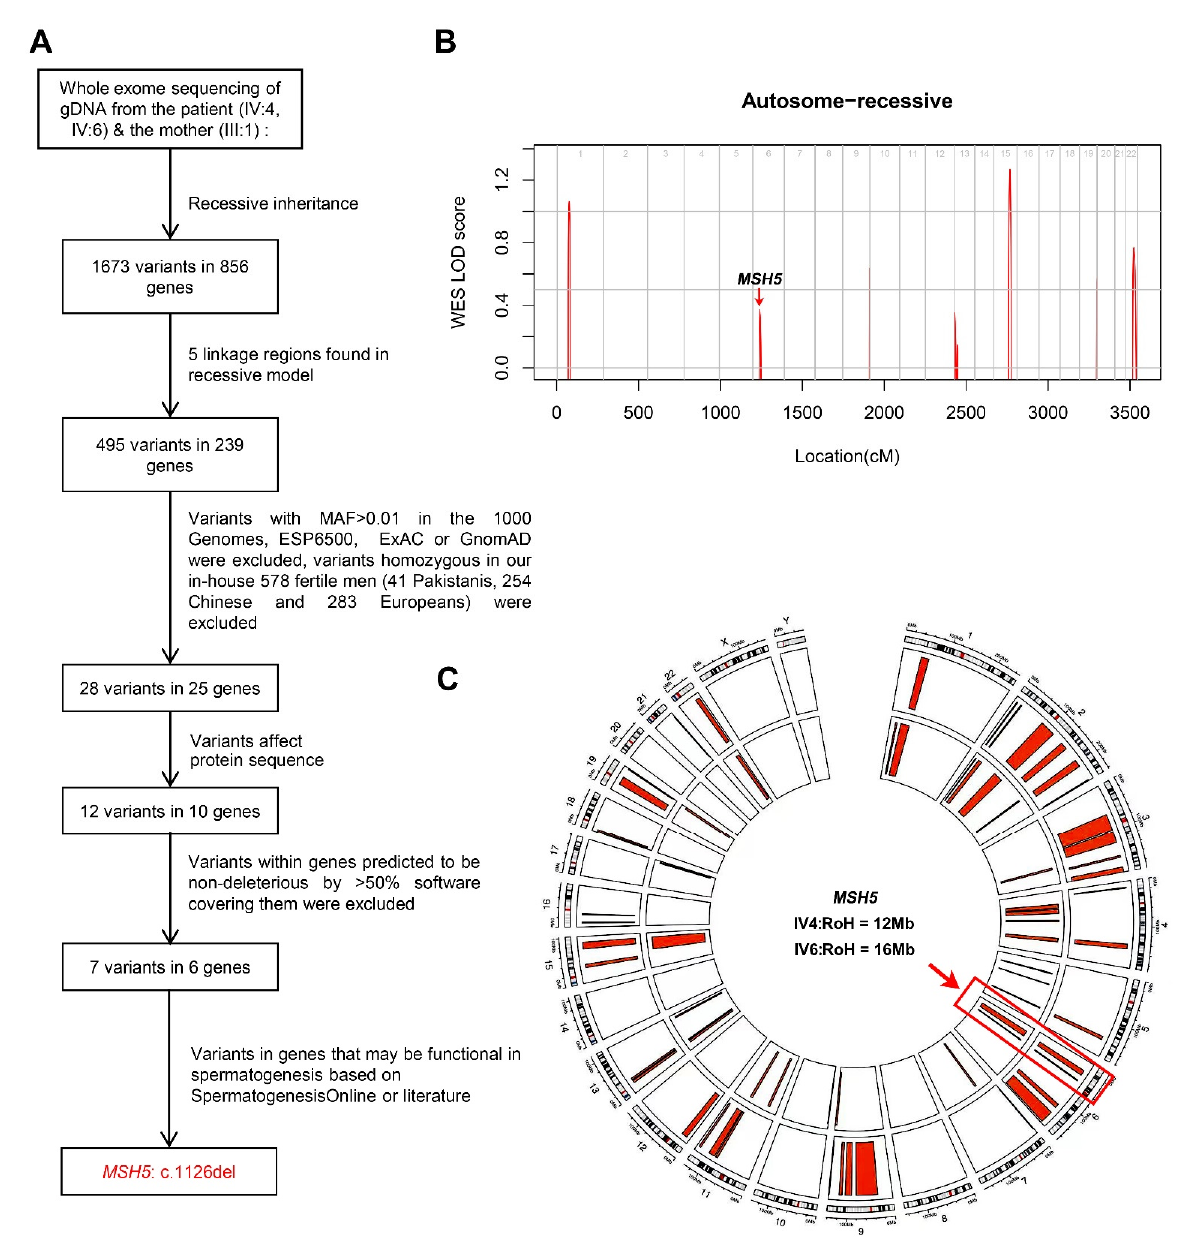
Figure 2. The workflow for the whole-exome sequencing data analysis. ( A ) The WES data analysis pipeline. MAF, minor allele frequency. ( B ) Genome-wide logarithm of the odd scores (LOD) using WES-derived genotypes for the family. ( C ) Homozygosity mapping analysis for individuals carrying the MSH5 mutation.